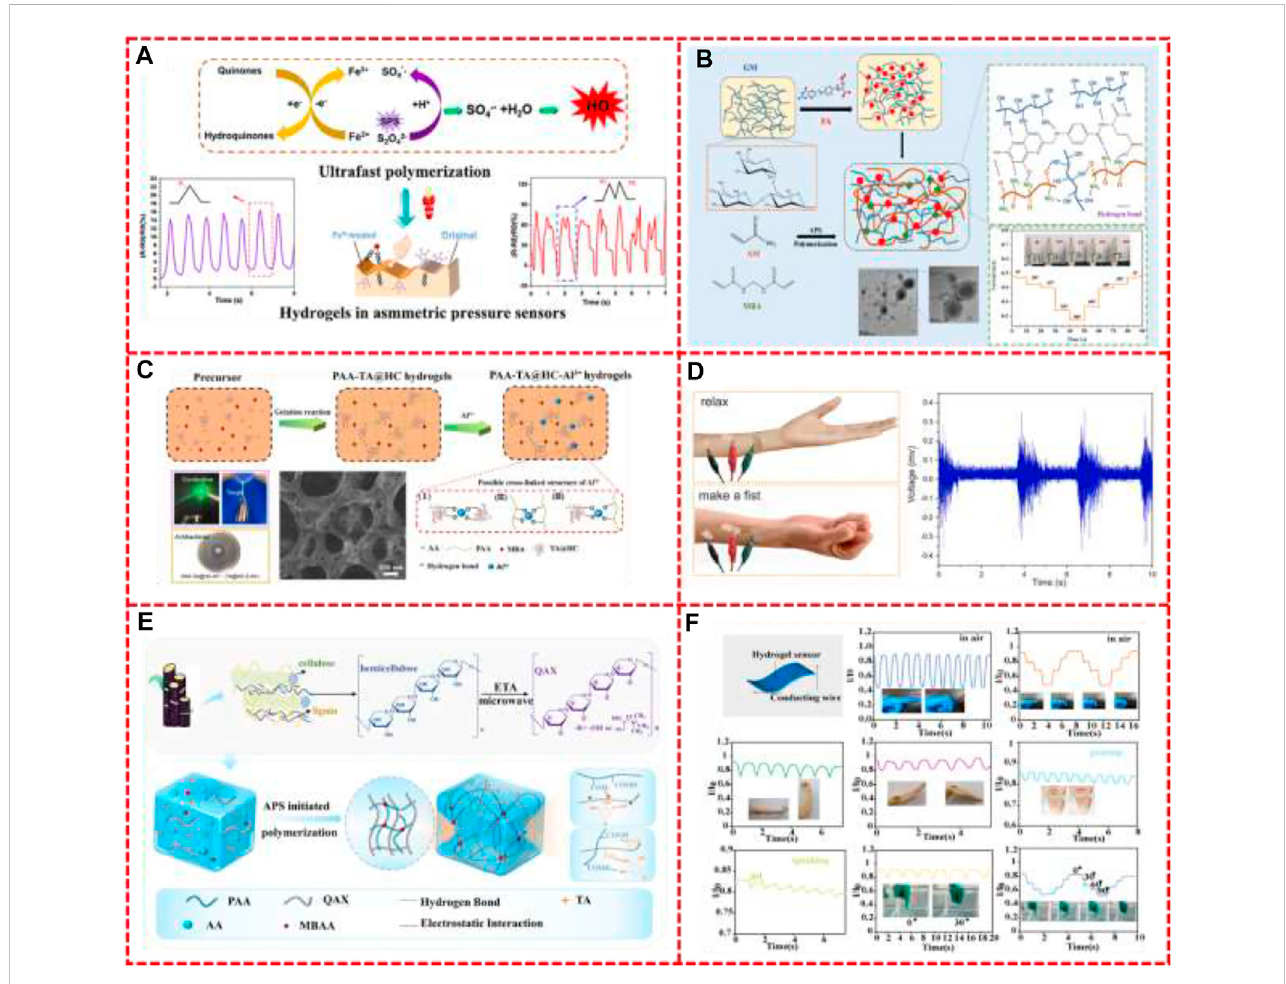
FIGURE 4 (A) Mechanism and pressure sensor signals recorded of PAA/TA@HC/Fe 3+ hydrogels with or without Fe 3+ treatment, (B) Schematic illustration of the preparation process of GM hydrogels and monitor arm bending as a strain sensor, (C) A schematic diagram of the ionic PAA-TA@HC-Al 3+ hydrogel synthesis processand mechanism, (D) PAA-TA@HC-Al 3+ hydrogel actsas aself-adhesive sensor,which canEMGsignals, (E) FabricationofthePAA-QAX-TA hydrogels, (F) PAA-QAX-TA hydrogel-based sensor model and sensing performance test, Reproduced from: (A) Gong et al. (2022b), ACS; (B) Ling et al. (2022), Elsevier; (C) Gong et al. (2022a), Elsevier; (D) Gong et al. (2022a), Elsevier; (E) Chang et al. (2022), Elsevier; (F) Chang et al. (2022),